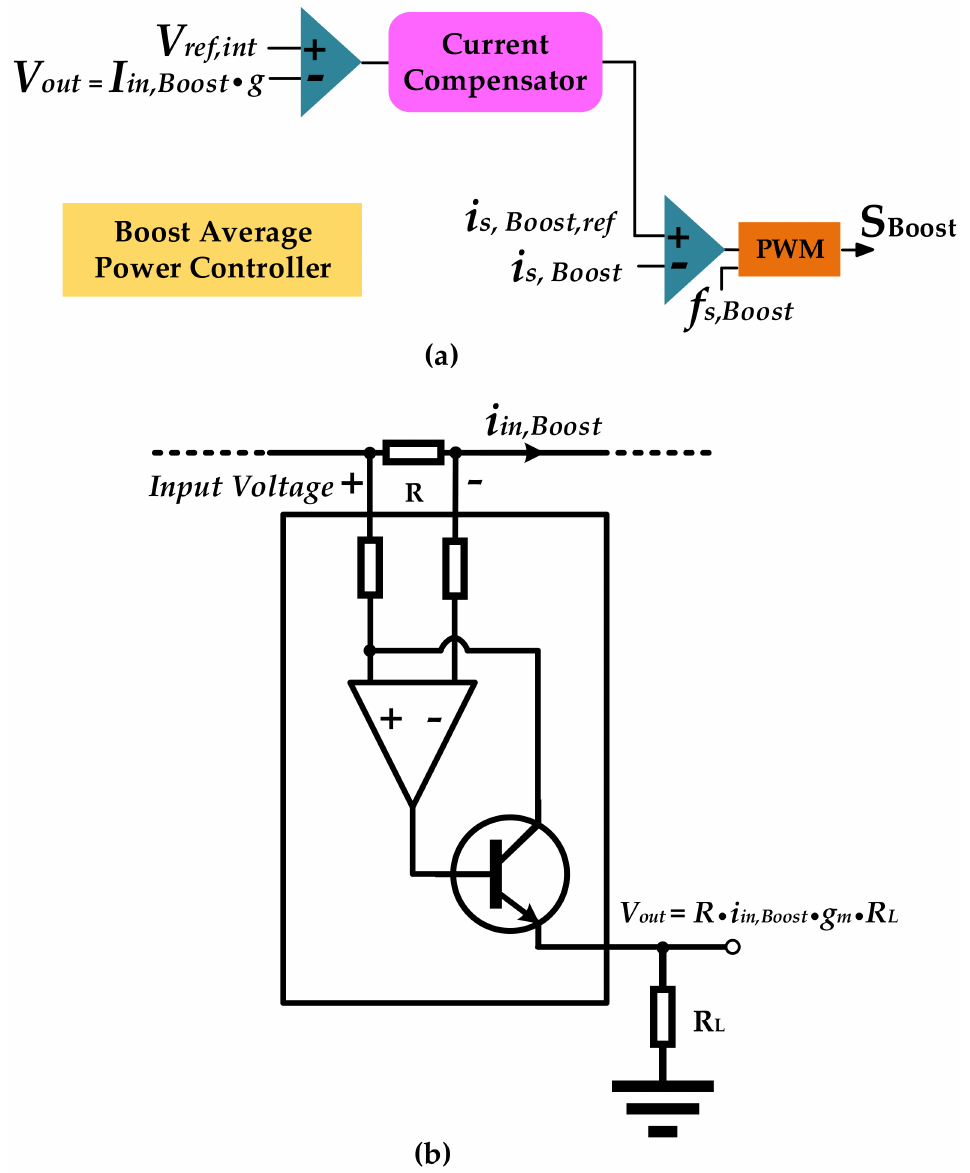
Figure 5. Control scheme of the Boost converter; ( a ) Average Power Control implementation. ( b ) OTA application